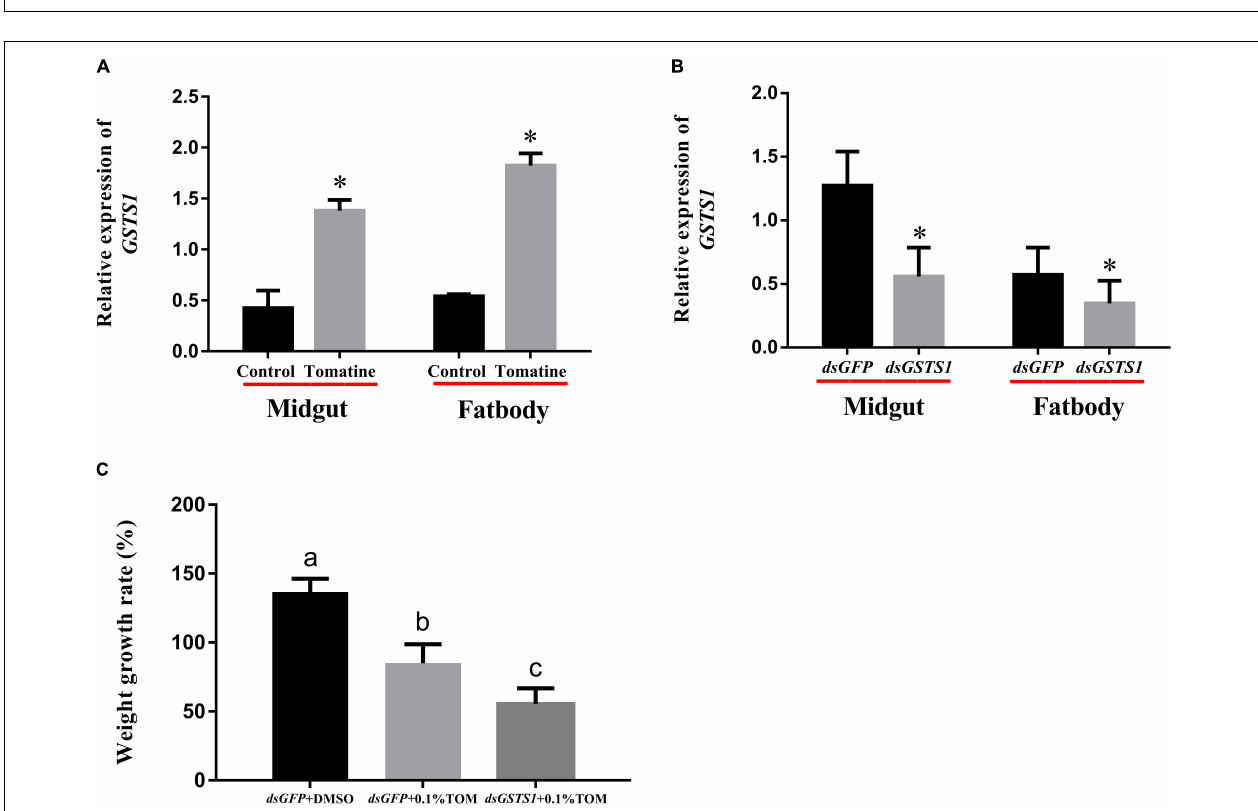
FIGURE 5 | The qRT-PCR analysis of GSTS1 expression in various S. litura tissues and life stages. (A) Relative spatial expression of GSTS1 ; the different life stages include 2-day-old 1st, 2nd, 3rd, 4th, 5th, and 6th (last) instar larvae, pupae, and adults. (B) Relative temporal expression of GSTS1 ; the different tissues include the cuticle, brain, midgut, fat body, and hemolymph. The different letters on the error bars indicate significant differences ( p < 0.05, Duncan’s multiple range test) among the developmental stages and tissues.